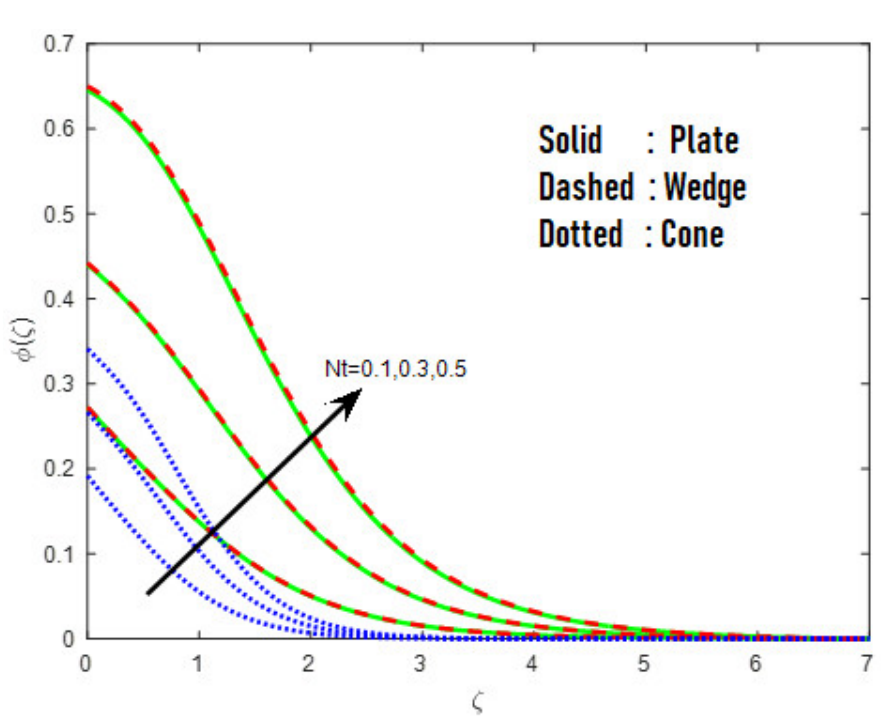
        . Figure 16. Nt vs. φ ( ζ ) .